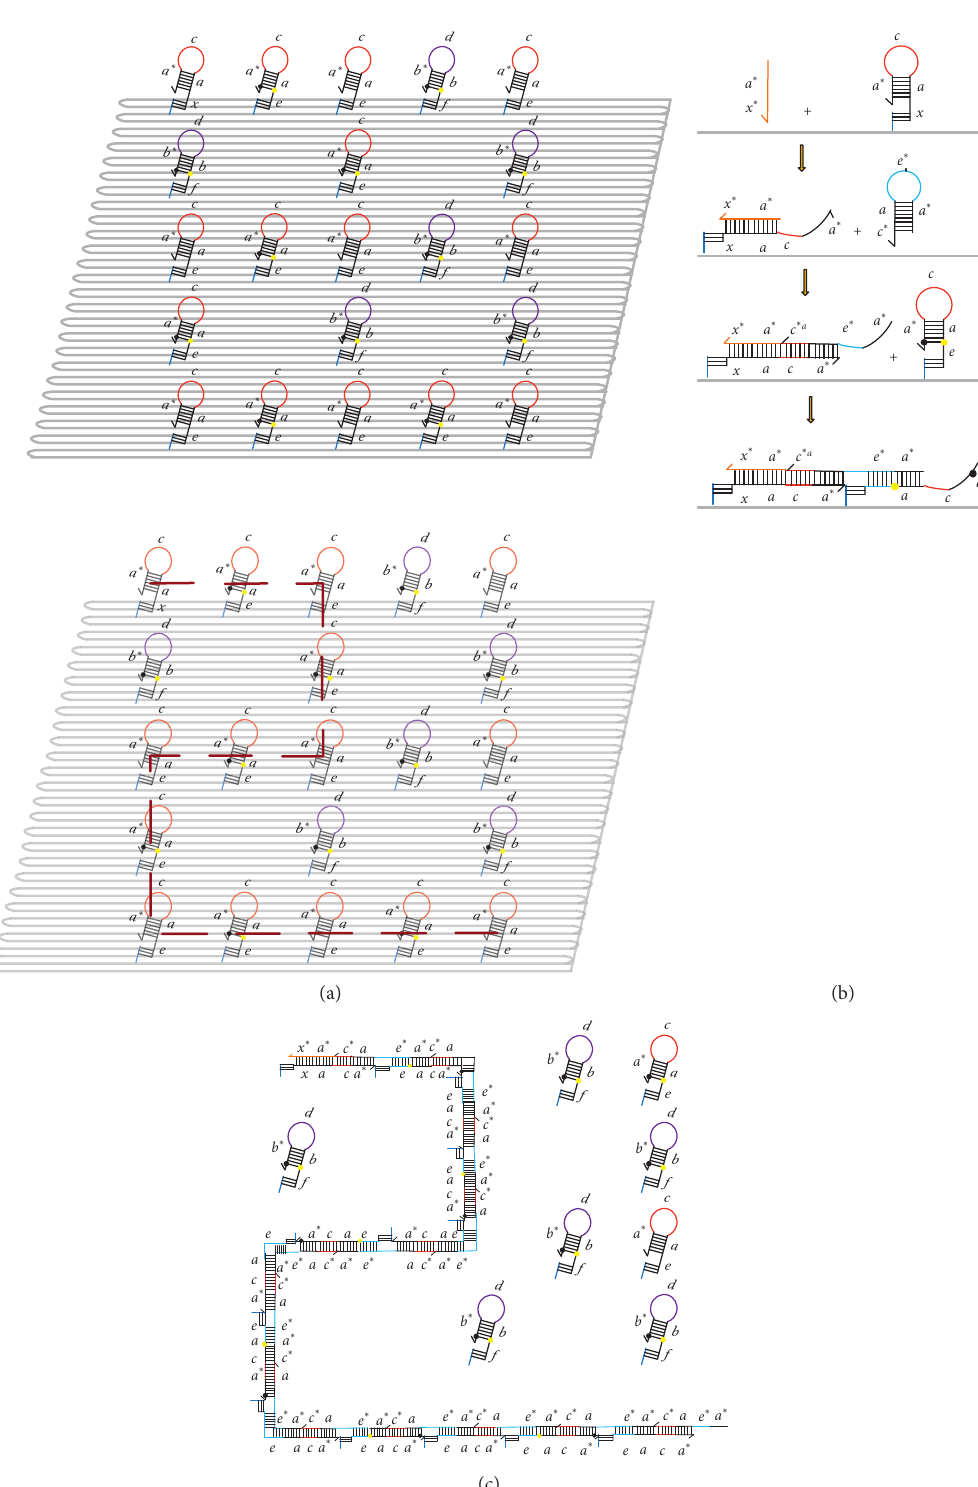
Figure 3: (a) The hairpin structure and cipher pattern designed on origami base; (b) the opening process after adding the cipher chain; (c) the cipher pattern after